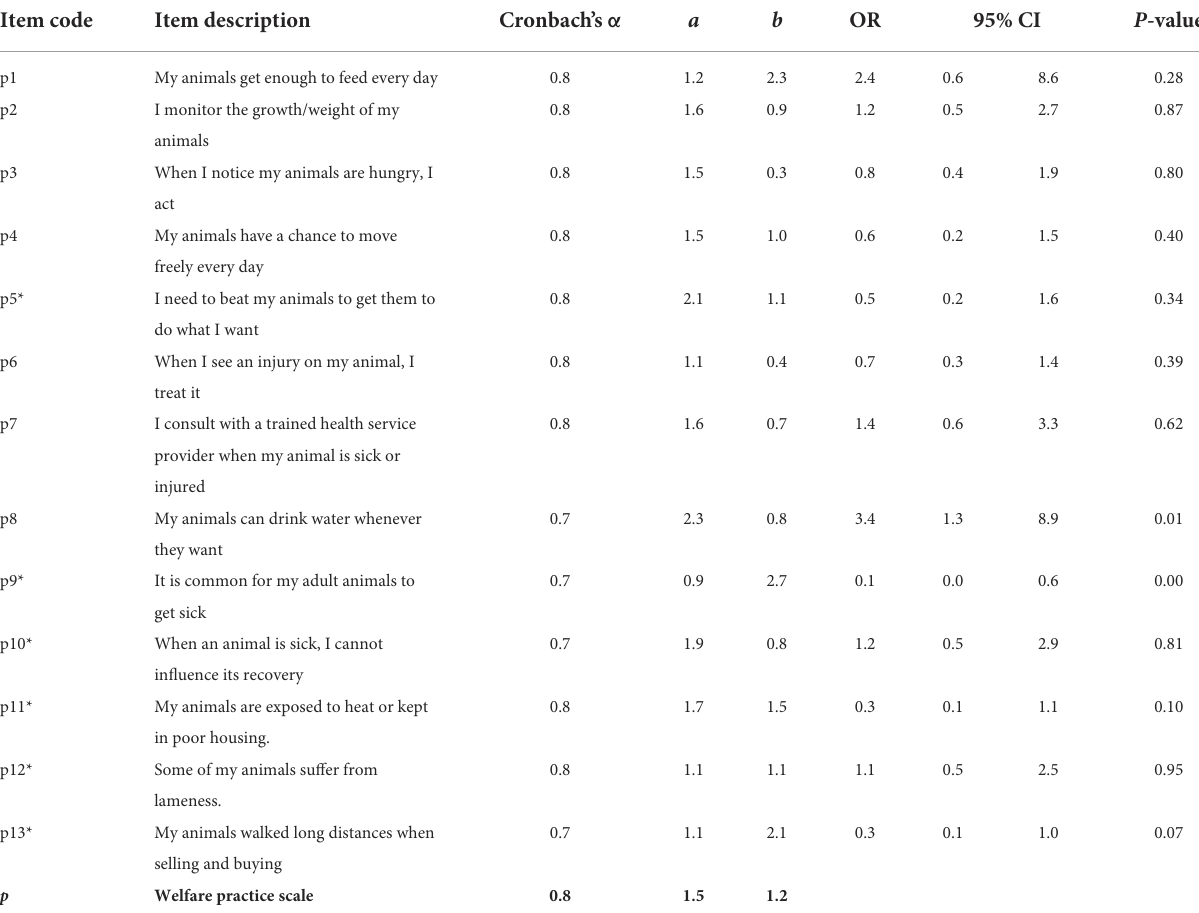
TABLE 6 Cronbach’s alpha, IRT parameter estimates, and uniform DIF for animal welfare practice